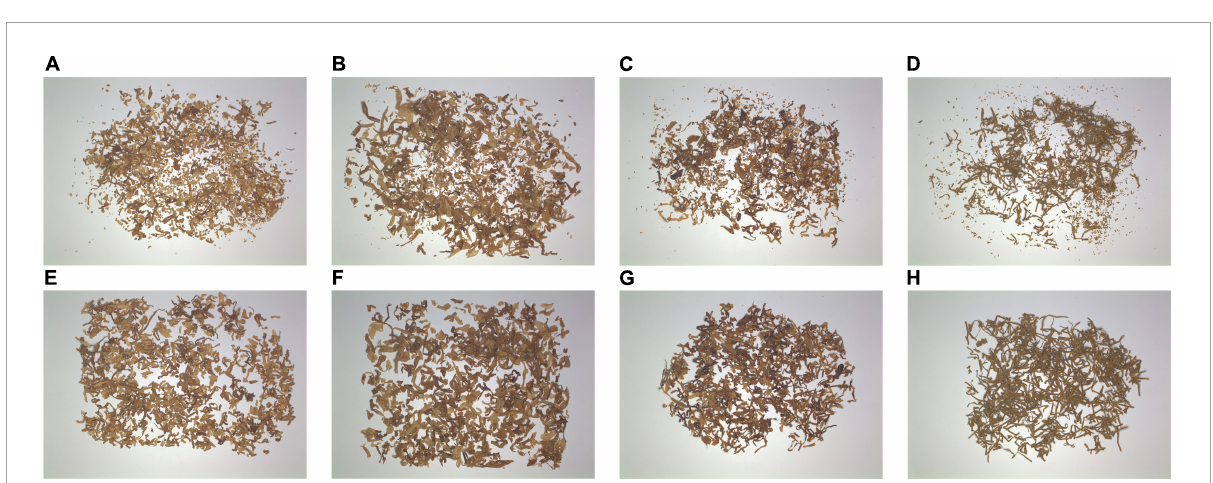
FIGURE1 Research flow chart.